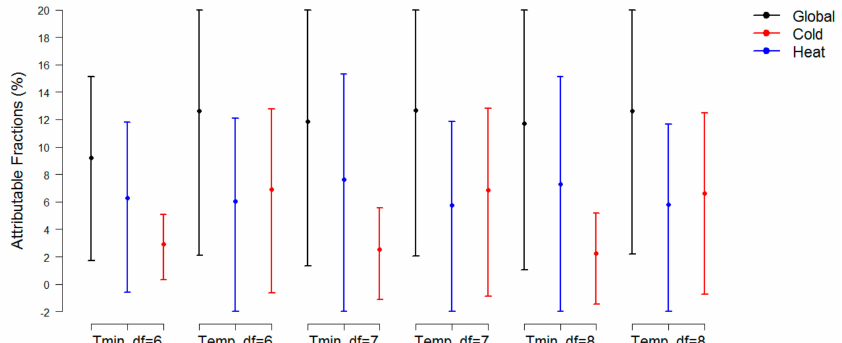
Figure 8. Total attributable risk of mortality due to combined hot / cold for di ff erent degrees of freedom and temperature variables. Temp: Using minimum temperature in winter and maximum temperature in summer (original variable used) vs. Tmin: Using minimum